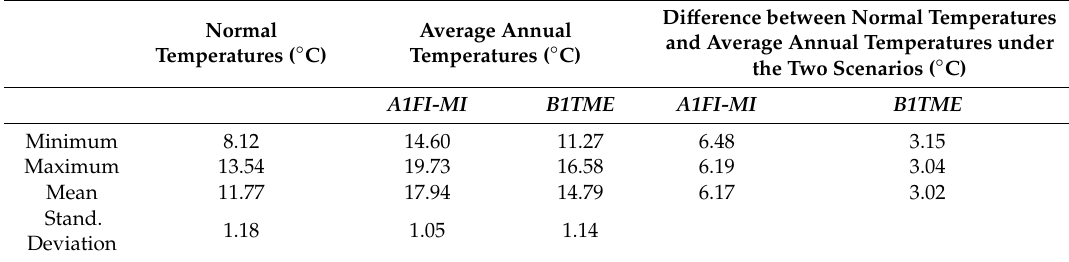
Table 5. Summary statistics of precipitation from PRISM data and based on the two scenarios from Figure 3 images.